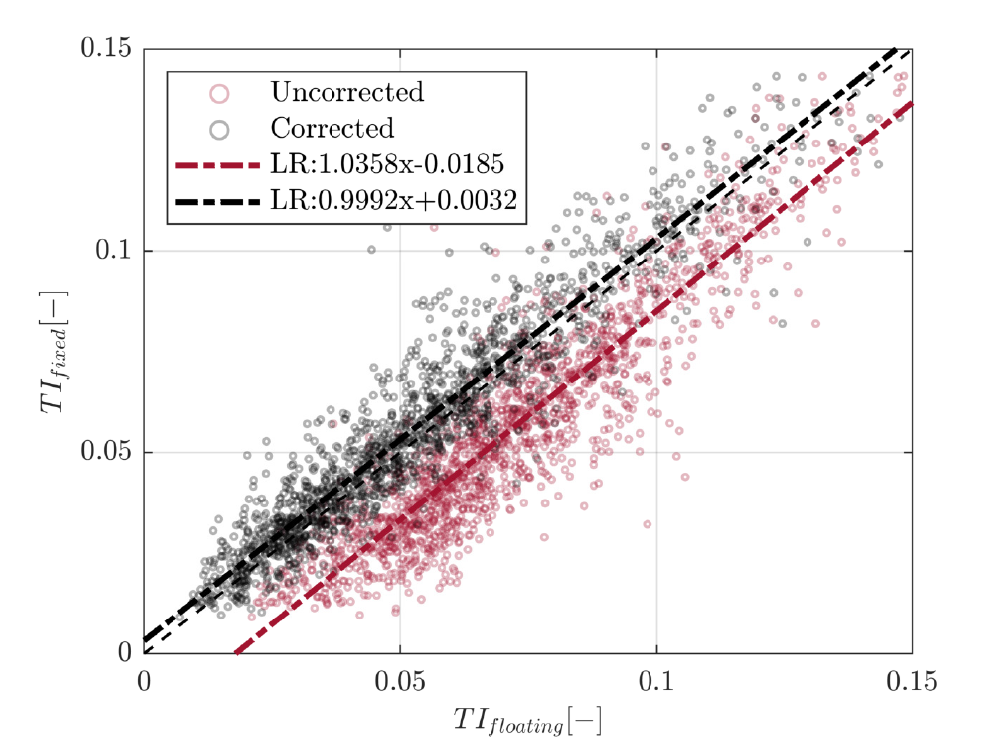
Figure 10. Scatter plot comparing the TI measured by the FDWL with reference to the fixed Li- DAR, with and without correction (Red, without motion correction; Black, with motion correction). The dashed line indicates the ideal 1:1 line. Dot-dashed lines indicate corresponding color-coded linear